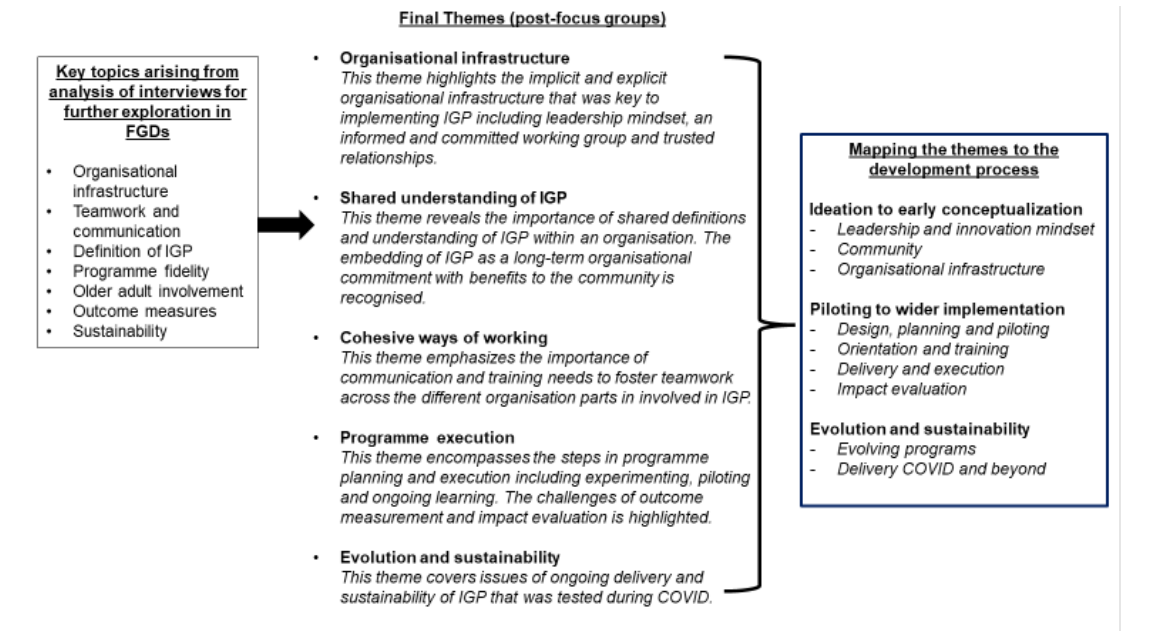
Figure 1. Analytic process highlighting key themes mapped to the IGP development process.